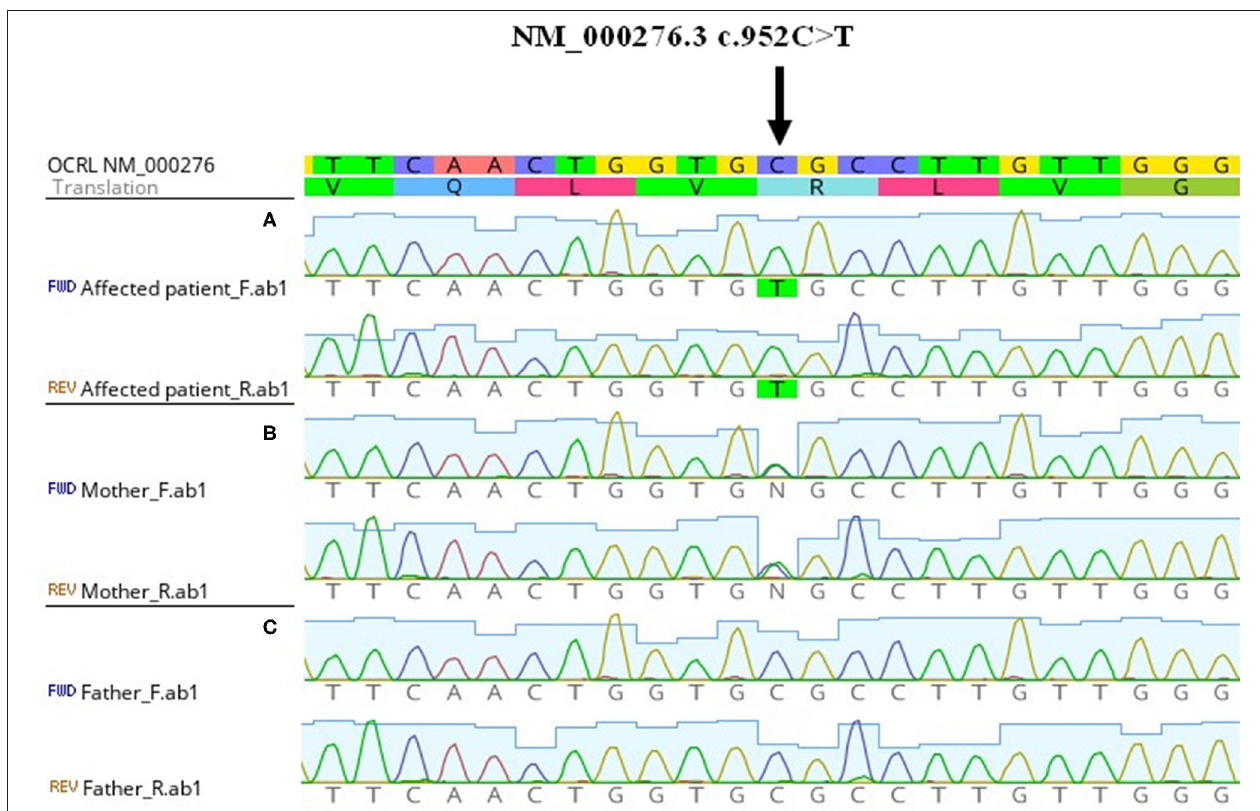
FIGURE 2 | Genetic finding of OCRL pathogenic variant. From above: nucleotide reference sequence, amino acid reference sequence, electropherogram from Sanger sequencing of aligned forward and reverse sequences. The picture was obtained from Geneious Prime software. (A) Hemizygous NM_000276.3c.952C > T in affected patient. (B) Heterozygous NM_000276.3c.952C > T in the mother without a disease phenotype. (C) Negative sequencing results of the healthy